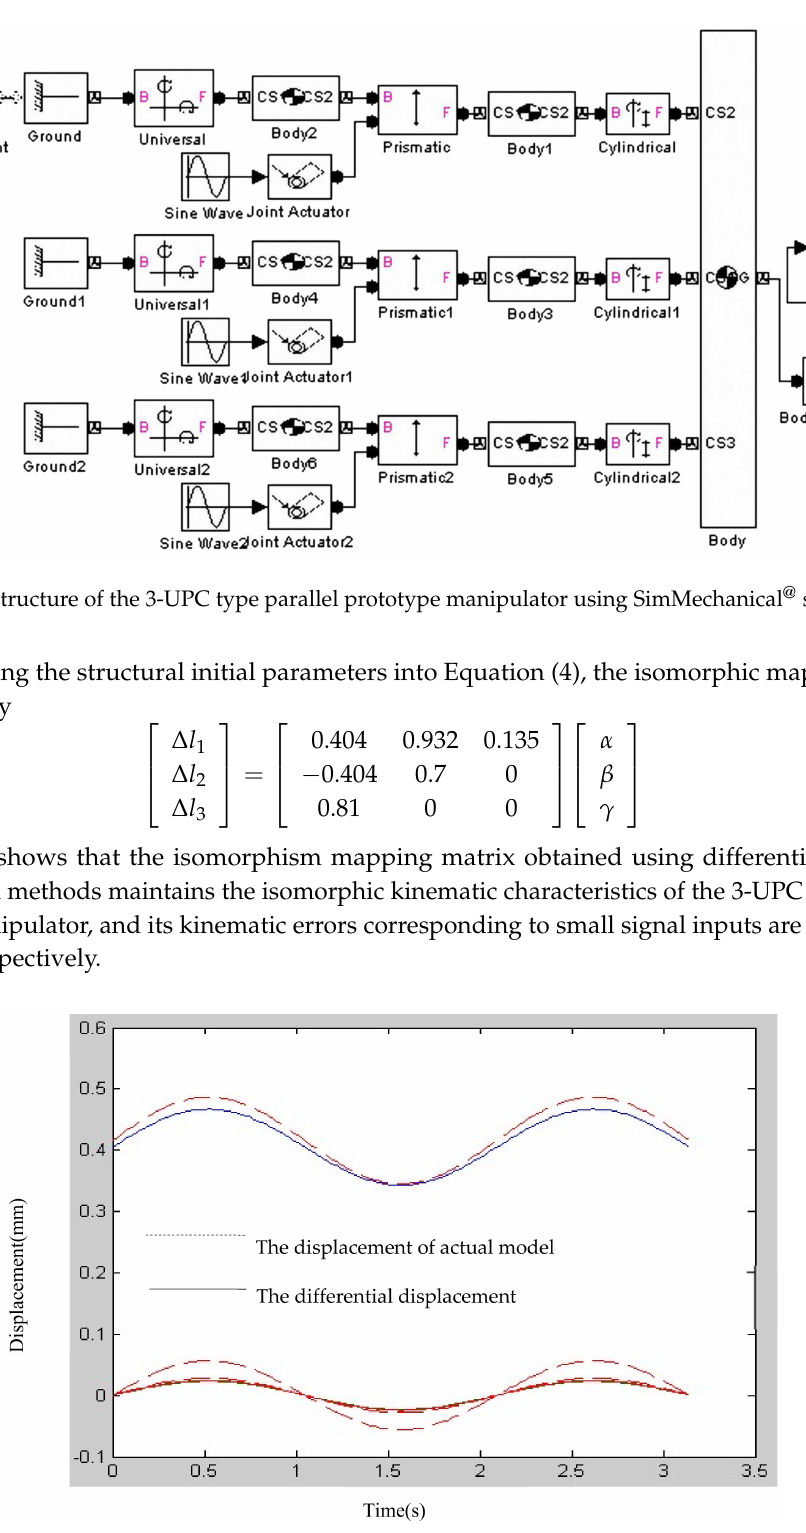
Figure 6. Forward kinematic comparison between differential kinematic approximation method and actual model of the 3-UPC type parallel prototype